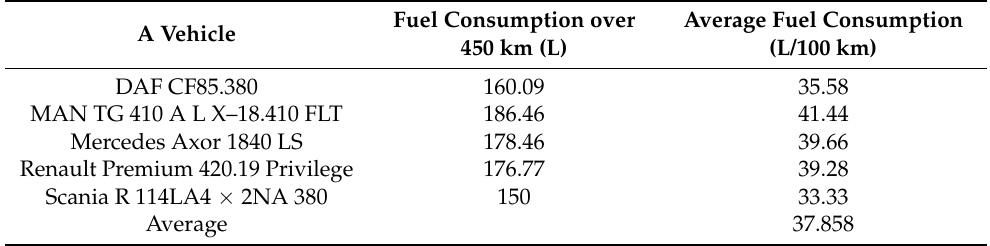
Table 4. Fuel consumption—tractors with semi-trailers in Poland, 2001. Fuel Consumption A Vehicle